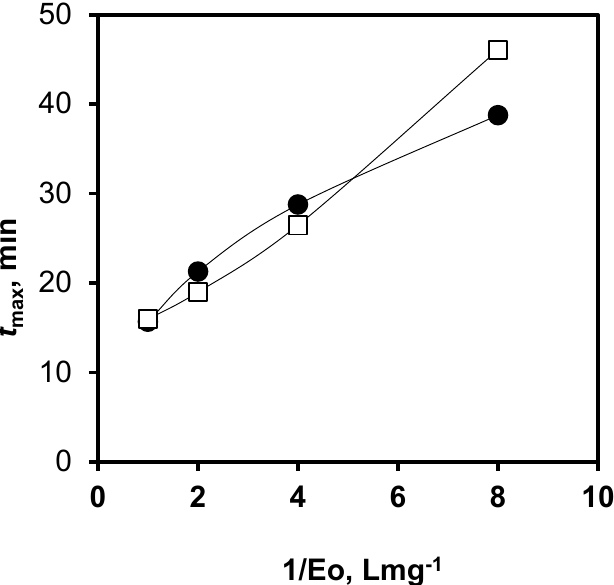
Figure 7. Experimental ( □ ) and calculated ( ● ) values of t max depending on the reciprocal values of enzyme concentration.